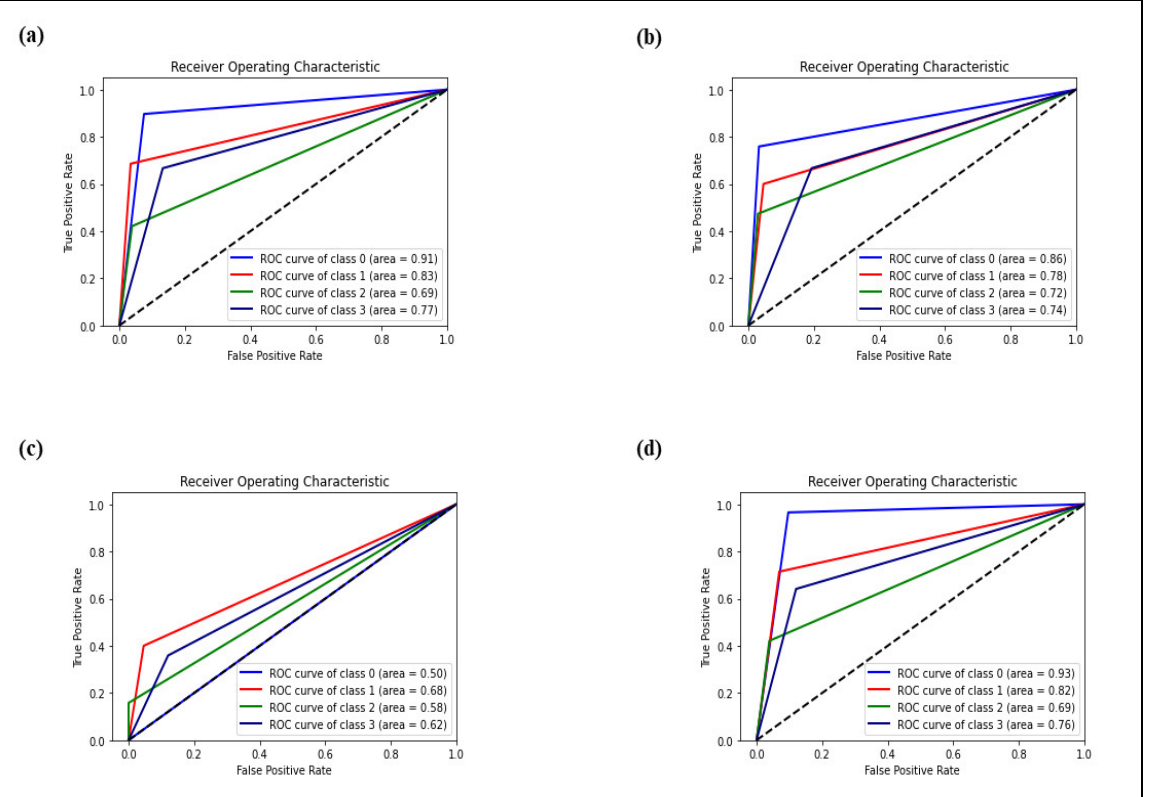
Figure 8. ROC curve for ( a ) Model 1, ( b ) Model 2, ( c ) Model 3 and ( d ) Model 4.